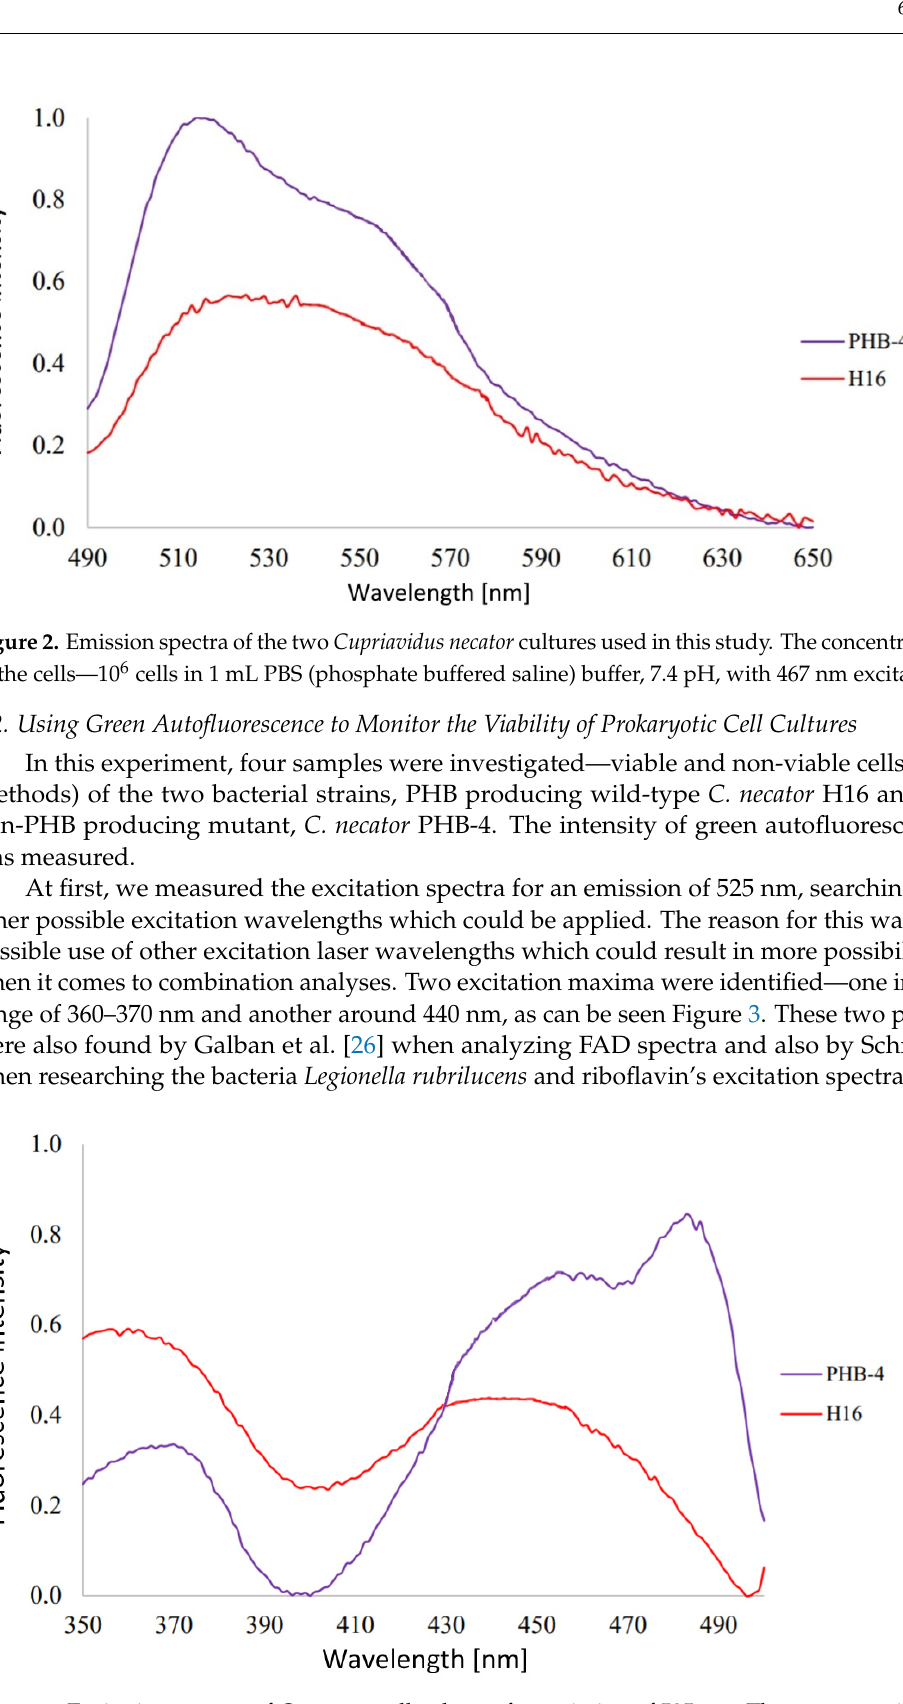
Figure 3. Excitation spectra of C. necator cell cultures for emission of 525 nm. The concentration of the cells—10 6 cells in 1 mL PBS buffer, 7.4 the cells—10 6 cells in 1 mL PBS buffer, 7.4 pH.